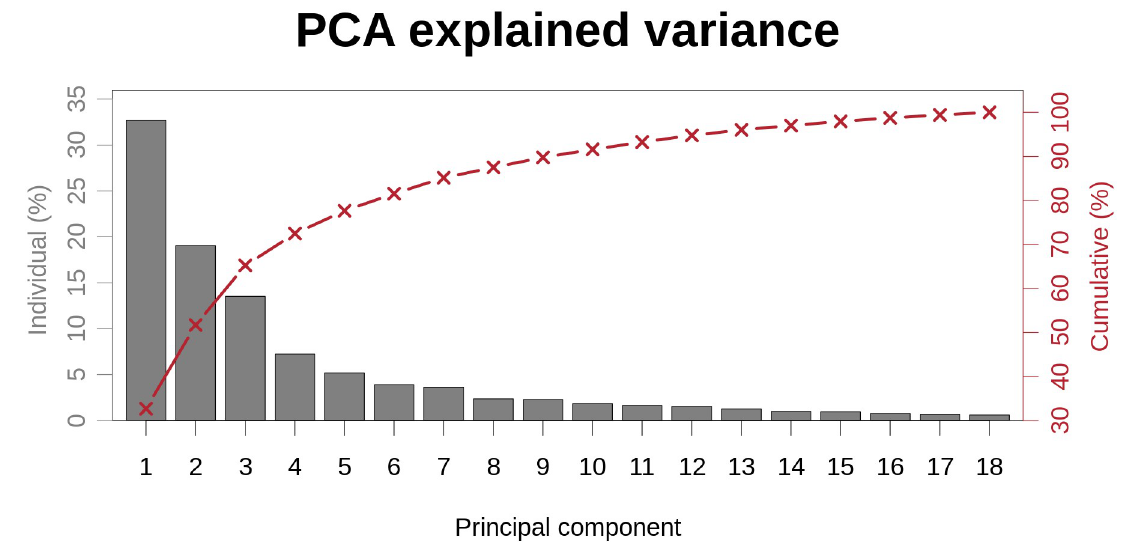
Fig 4. Cumulative and individual explained variance ratio of each PCA mode in the CT